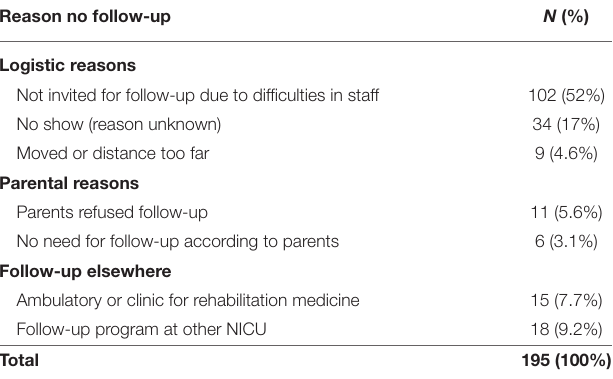
TABLE 2 | Reasons for no